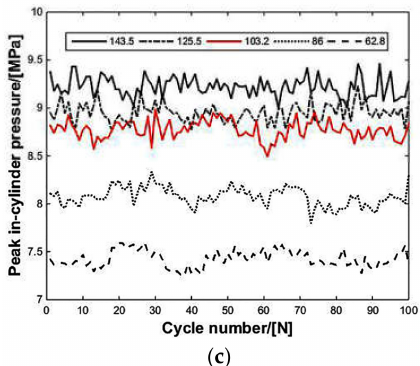
Figure 4. Effects of different injection parameters on the combustion stability. ( a ) Different pre-injection